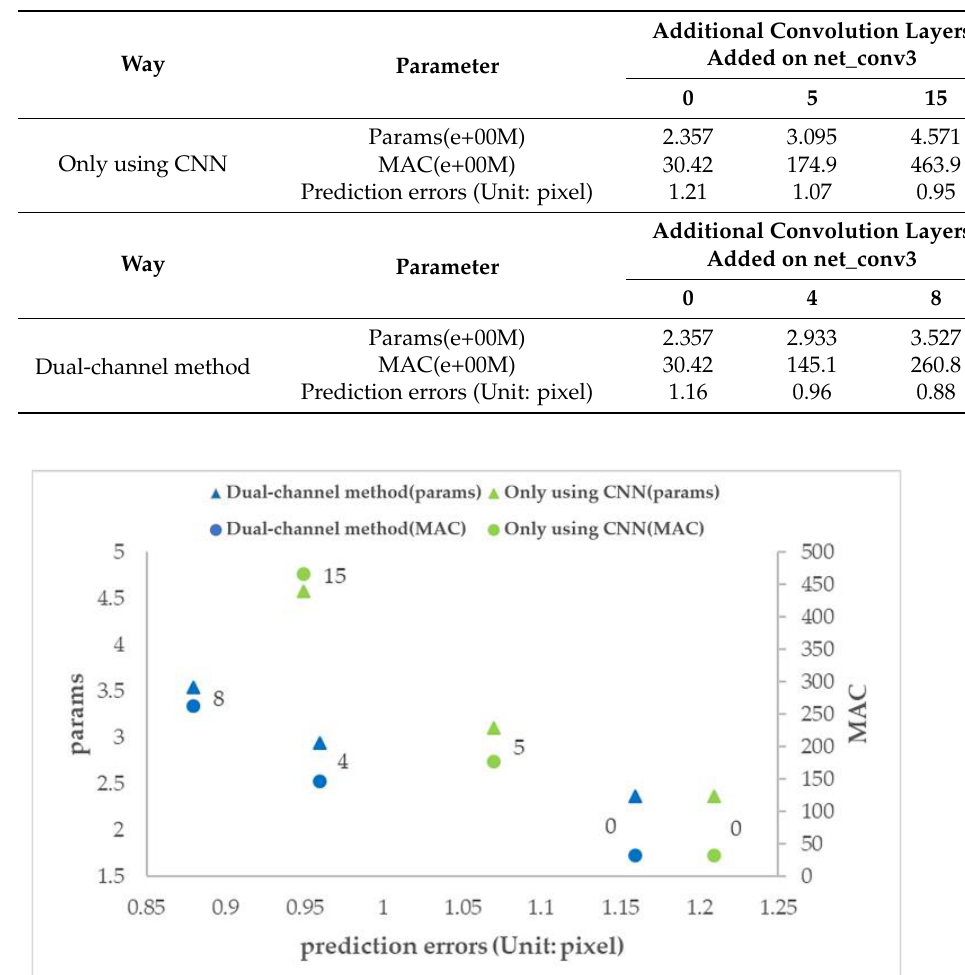
Figure 20. Prediction error and computational efficiency of different networks.